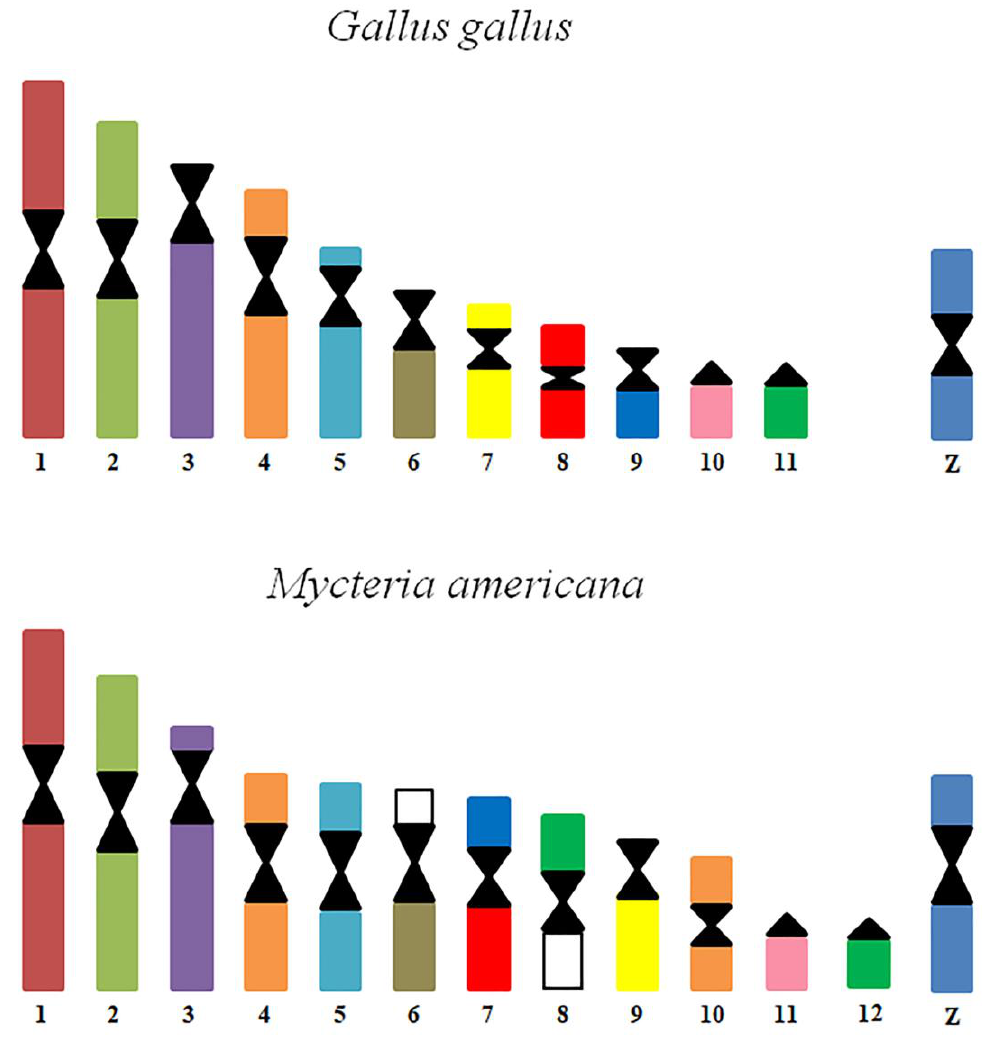
Figure 5. Homology map between M. americana and G. Gallus . The regions with homologies are indicated by color.